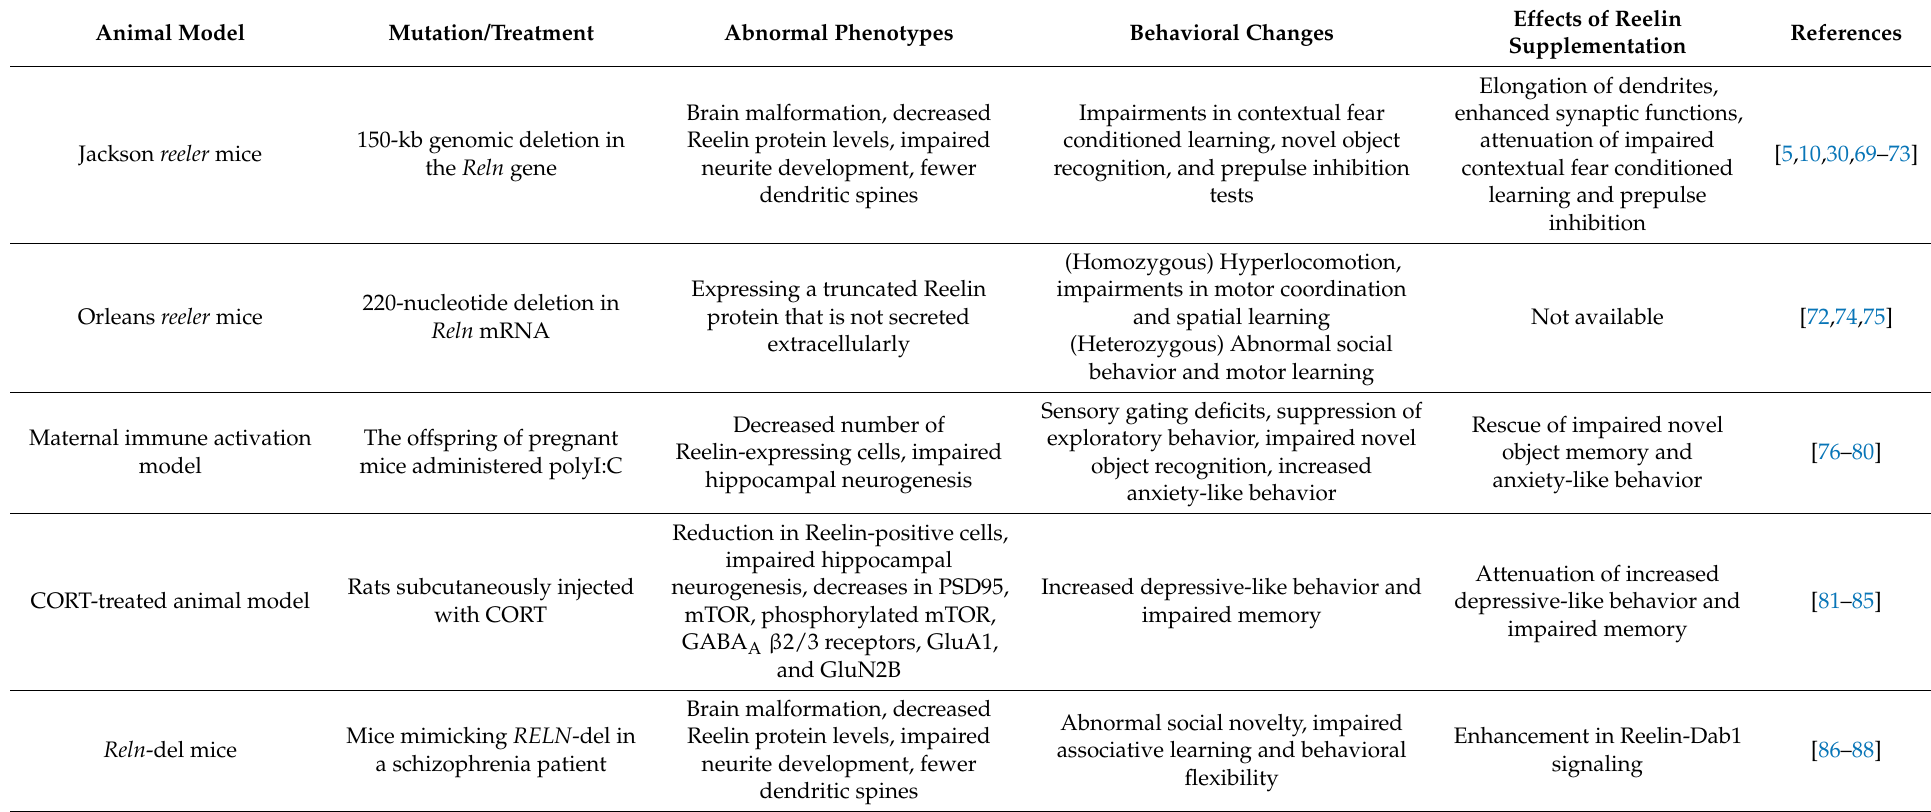
Table 1. Summary of animal models based on Reelin